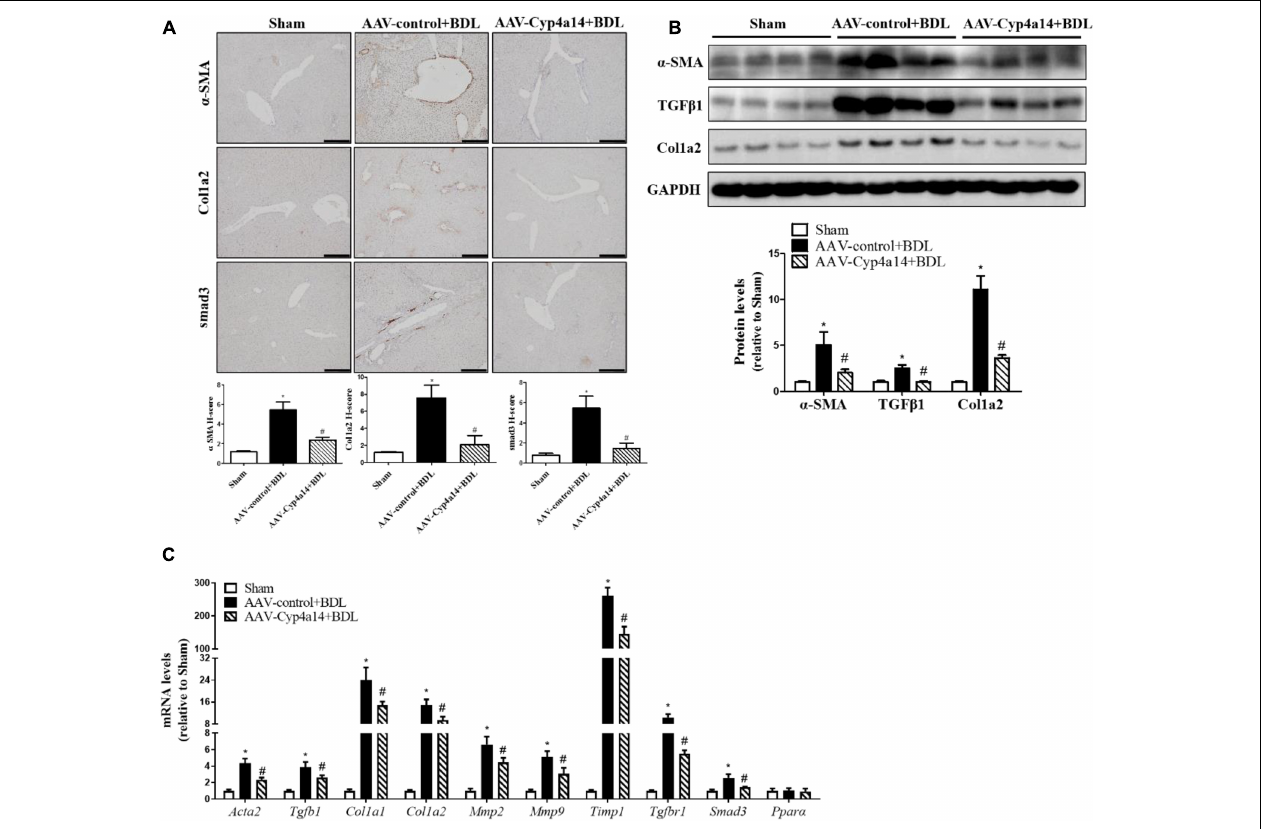
FIGURE 5 | Hepatic Cyp4a14 overexpression inhibited α -smooth muscle actin ( α -SMA), Col1a2, and smad3 expression in bile duct ligation (BDL) mice. (A) Cyp4a14 gene overexpression obviously attenuated BDL-induced α -SMA, Col1a2, and smad3 protein expression in the livers as assessed by an immunostaining analysis. (B) Western blot assay showing the protein levels of α -SMA, TGF- β 1, and Col1a2. (C) Quantitative RT-PCR analysis showing the mRNA levels of Acta2 , Tgfb1 , Col1a1 , Col1a2 , Mmp2 , Mmp9 , Timp1 , TgfbR1 , Smad3 , and Ppar α . n = 6–7. * p < 0.05, Sham and AAV-control + BDL. # p < 0.05, AAV-control + BDL and AAV-Cyp4a14 + BDL. Scale bar = 100 µ m.